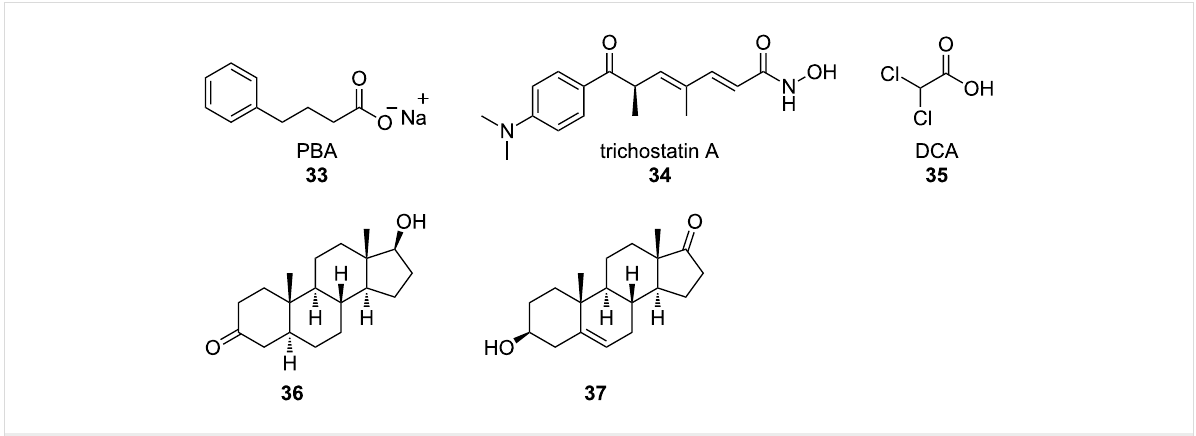
Figure 14: Probes used to elucidate the roles of distinct gene-expression profiles in ALS patients.